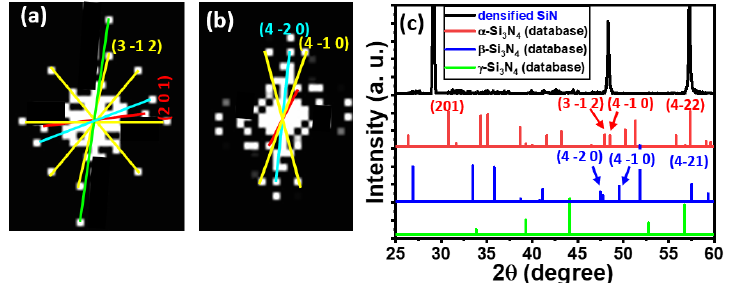
Figure 7. ( a , b ) SAED patterns; and ( c ) XRD spectra acquired for the densified, polycrystalline Si 3 N 4 generated in proximity to the Ge QDs. The appearance of clear electron diffraction spots and XRD peaks is convincing evidence for the phase transition of the Si 3 N 4 from the amorphous to the densified polycrystalline state.